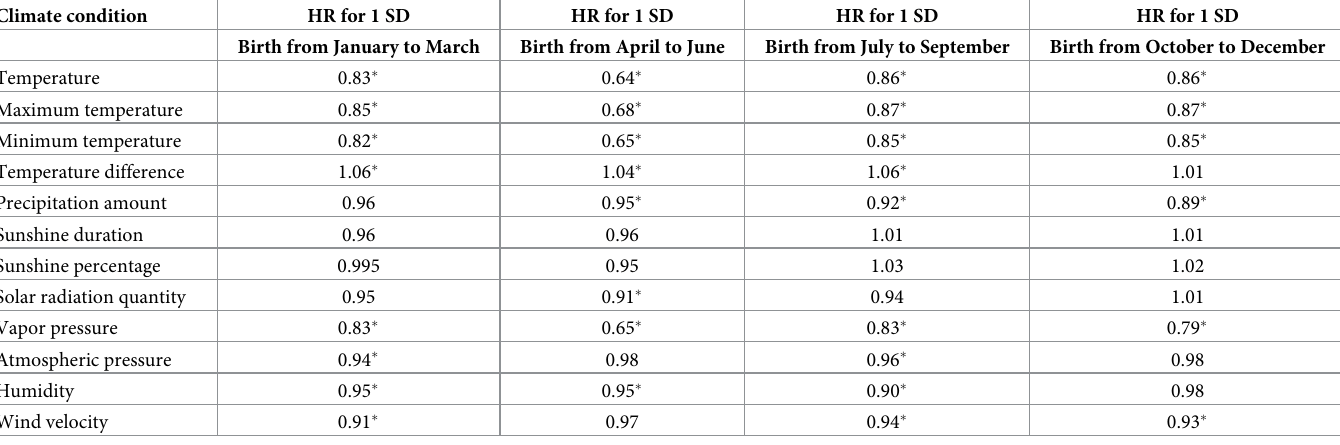
Table 2. Crude HRs of the incidence of atopic dermatitis for a one standard deviation increase in the mean climate condition from birth to 6 months by birth season. Climate condition HR for 1 SD HR for 1 SD HR for 1